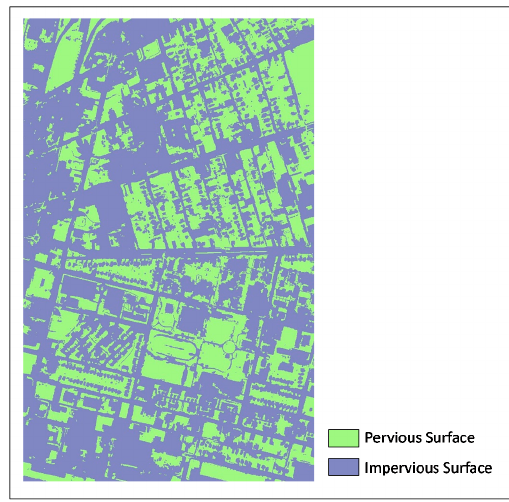
Figure 21. Impervious surface distribution map in 2011. Table 8. Confusion matrix and accuracy of the impervious surface distribution map.